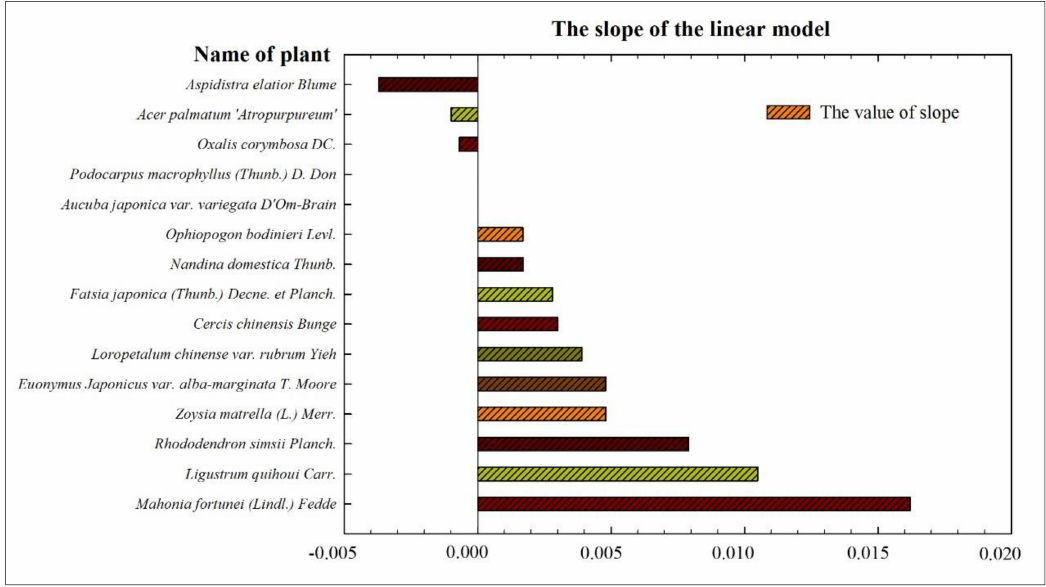
Figure 4. Slope ranking of the linear models in the 15 landscape plant